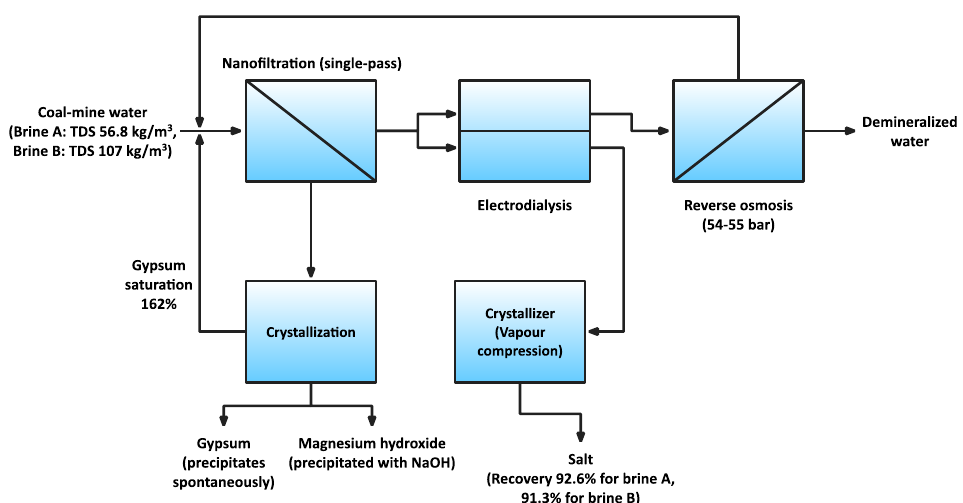
Figure 2. An overview of the proposed NF – ED – RO system, made with data from [27].